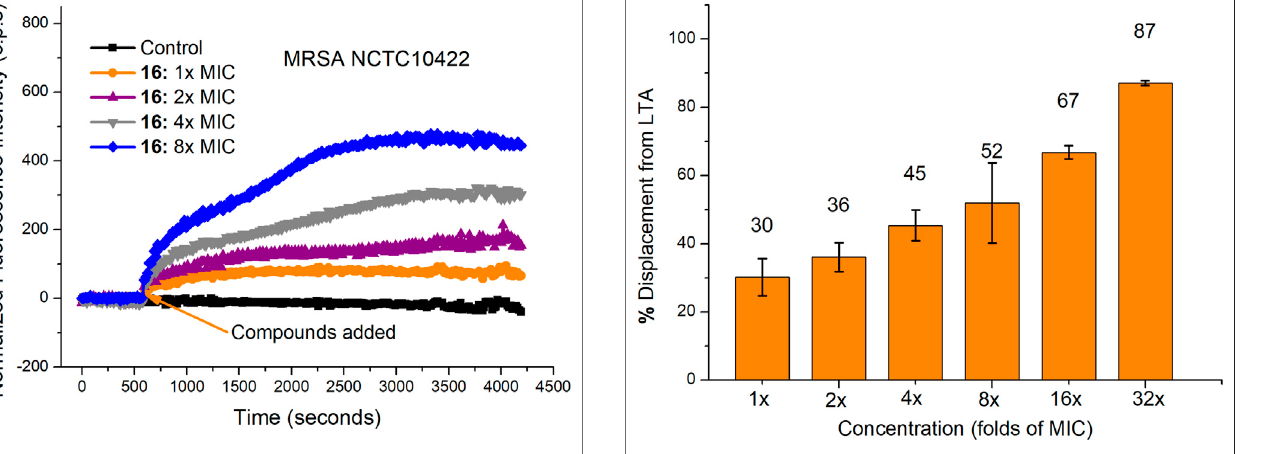
FIGURE 4 | The displacement of BODIPY-TR-cadaverine from LTA was caused by compound 16 . Data are presented as the average value of two independent